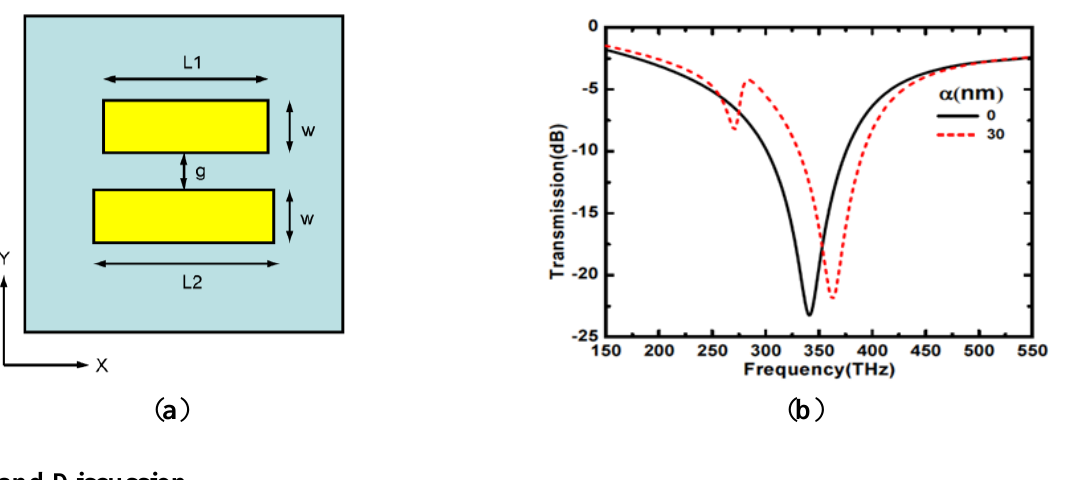
nanorods of lengths L and L are: width w = 70 nm, gap g = 50 nm. The gold thickness is 1 2 30 nm. The periodicity is 300 nm in both x and y directions. The incident wave is along the z direction. ( b ) Transmission spectra for the symmetric (solid line) and asymmetric (dashed line) dimers with α = 0 nm and α = 30 nm